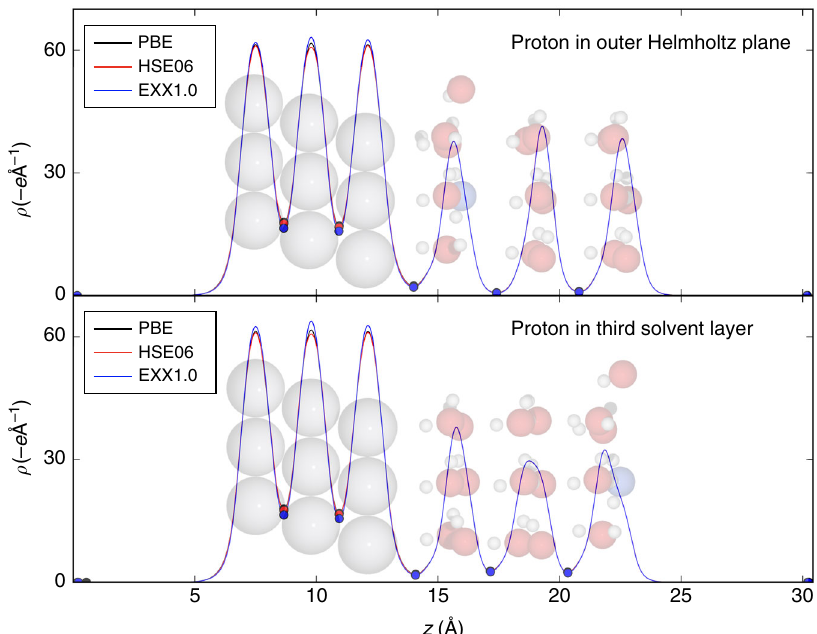
Fig. 2 Electron density analysis for the solvated proton. Plane-integrated electron density distribution as a function of the unit cell z -coordinate calculated with PBE (black), HSE06 (red), and EXX1.0 (blue) exchange-correlation functionals. The top and bottom panels show H 3 O + in the outer Helmholtz plane ( fi rst solvent layer) and third solvent layer, respectively. The plane-integrated charge for the solvated proton is fractional in the fi rst solvent layer with values of + 0.64, + 0.69, and + 0.71 e at the PBE, HSE06, and EXX1.0 levels of theory. These charges approach unity with values of + 0.86, + 0.88, and + 0.91 e , respectively, for the PBE, HSE06, and EXX1.0 functionals where the proton is in the third solvent layer. The charges on the proton obtained for each structure with all three functionals agree within 0.1